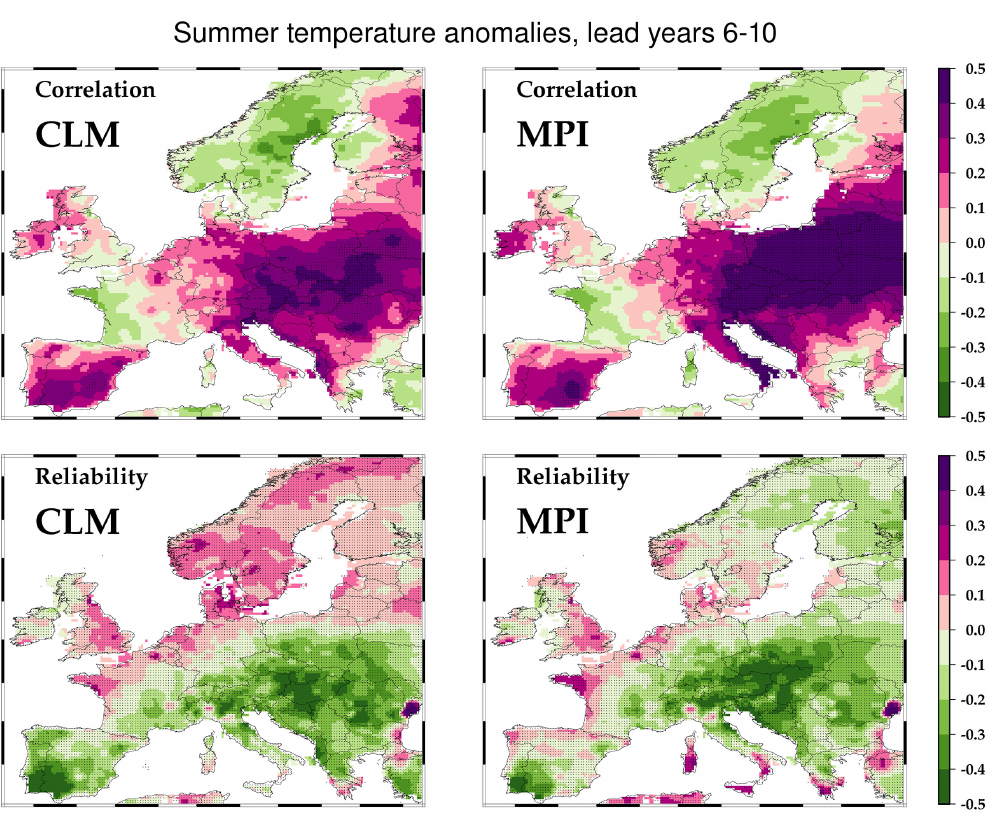
Figure 11. Summer half-year temperature anomaly means for lead years 6–10 from 1961 to 2010. The top panels show the correlation coefficient between E-OBS observations and CCLM (left) and MPI-ESM-LR (right). The bottom panels show the reliability of the CCLM (left) and MPI-ESM-LR (right) ensembles with respect to the E-OBS observations. Stippling indicates results, significant at the 10% level.